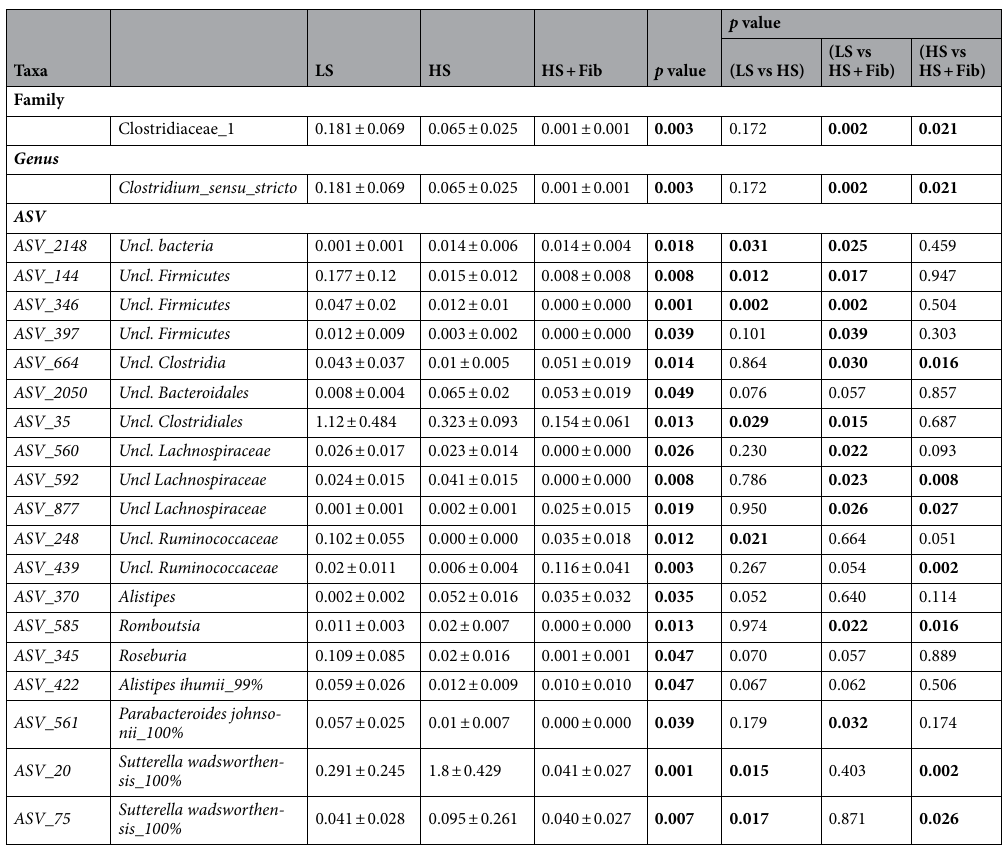
Table 5. Taxa and ASV significantly altered with high-severity of liver steatosis and liver fibrosis in obese individuals. Values refer to the mean percentage of relative abundance ± SEM . LS: Slight/moderate steatosis; HS: High-severity of steatosis; HS + Fib: High-severity of steatosis associated with fibrosis (n = 10 for LS, n = 18 for HS and n = 9 HS + Fib). Uncl.: unclassified. Kruskal–Wallis ANOVA test was performed for detecting significant differences between groups. Dunn’s multiple comparisons were then assessed. Significant differences are presented in